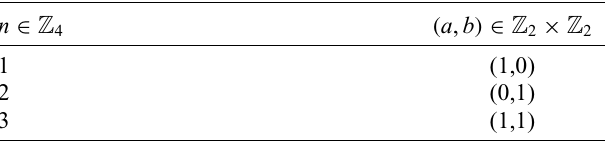
TABLE I. The elements of Z 4 labeled by elements of Z 2 × Z 2 . n ∈ Z